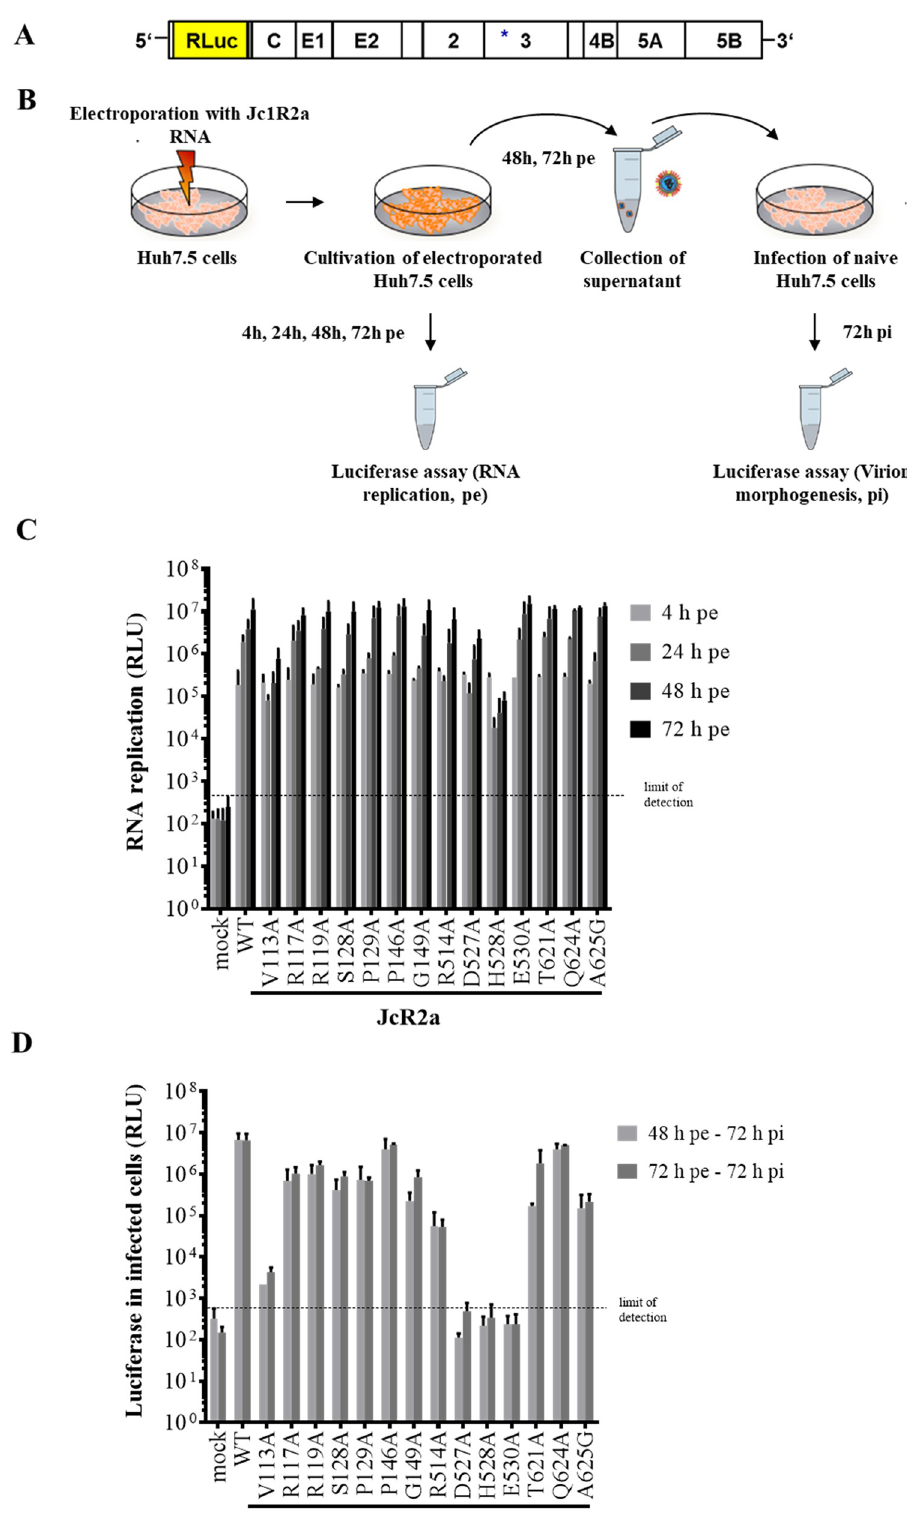
Fig 5. Impact of replication-competent NS3 surface mutations on the HCV genome replication and infectivity release. (A) Schematic diagram of the full-length monocistronic reporter virus (JcR2a; [70]). The HCV proteins